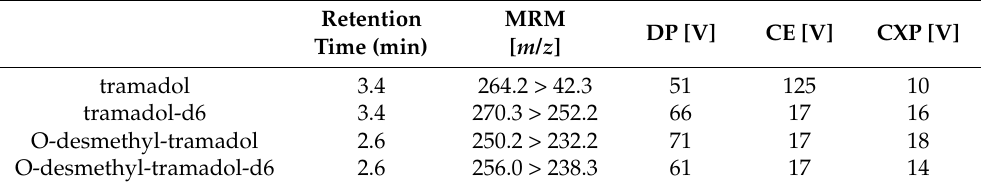
Table 1. Parameters of MS